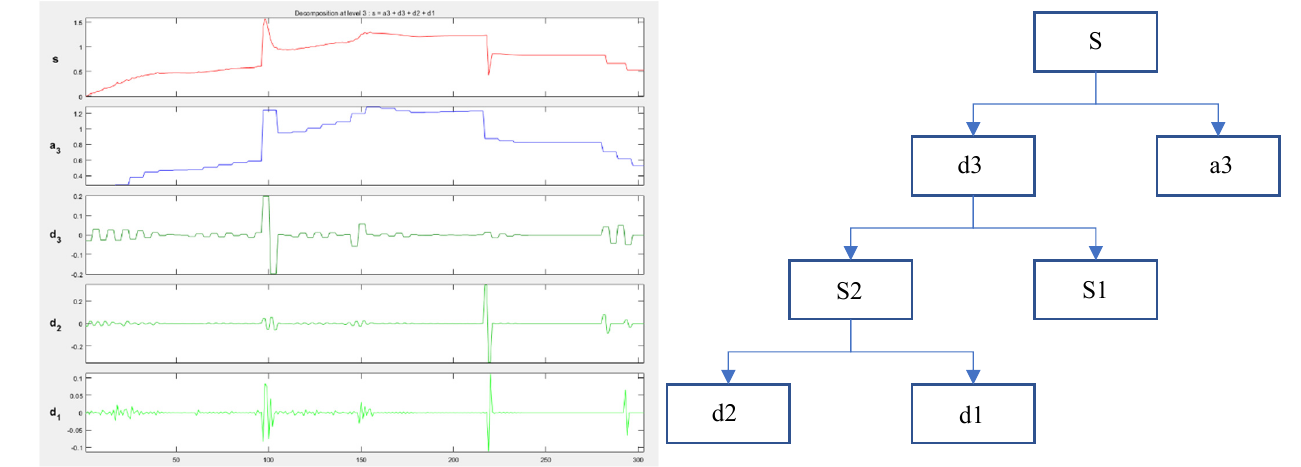
Figure 7. One-dimensional wavelet decomposition.